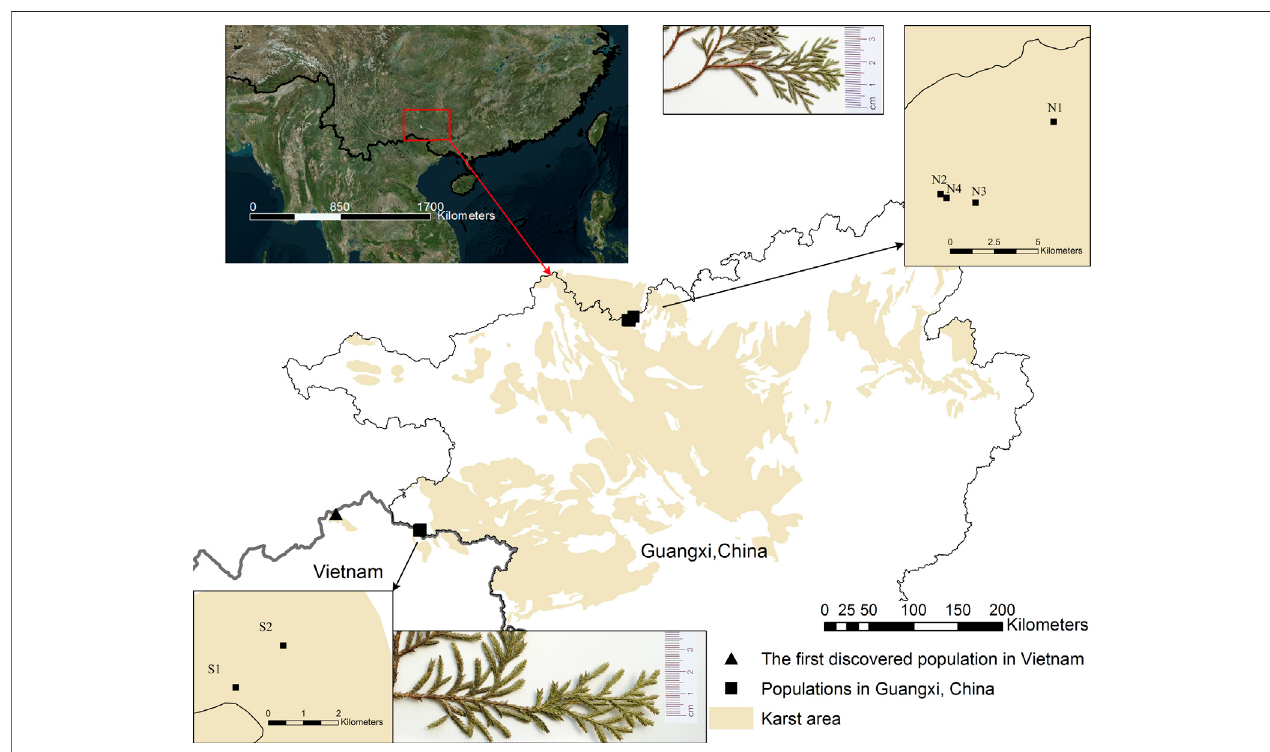
FIGURE1| Currentdistributionandleafappearanceof Xanthocyparisvietnamensis inGuangxi,Chinaandthe fi rstdiscoverysiteinVietnam.Populationsitecodes: N1,N2,N3,N4,S1,S2.Insetsintopmiddleandbottommiddleshowthesizesofthescale-likeleavesofindividualsfromnorthernandsouthernGuangxi,respectively.All the karst landforms in Guangxi and partial karst landforms in the other regions are showed by the yellow marker. See a direct comparison of scale-like leaf size between individuals from northern and southern Guangxi in Supplementary Figure S1 .